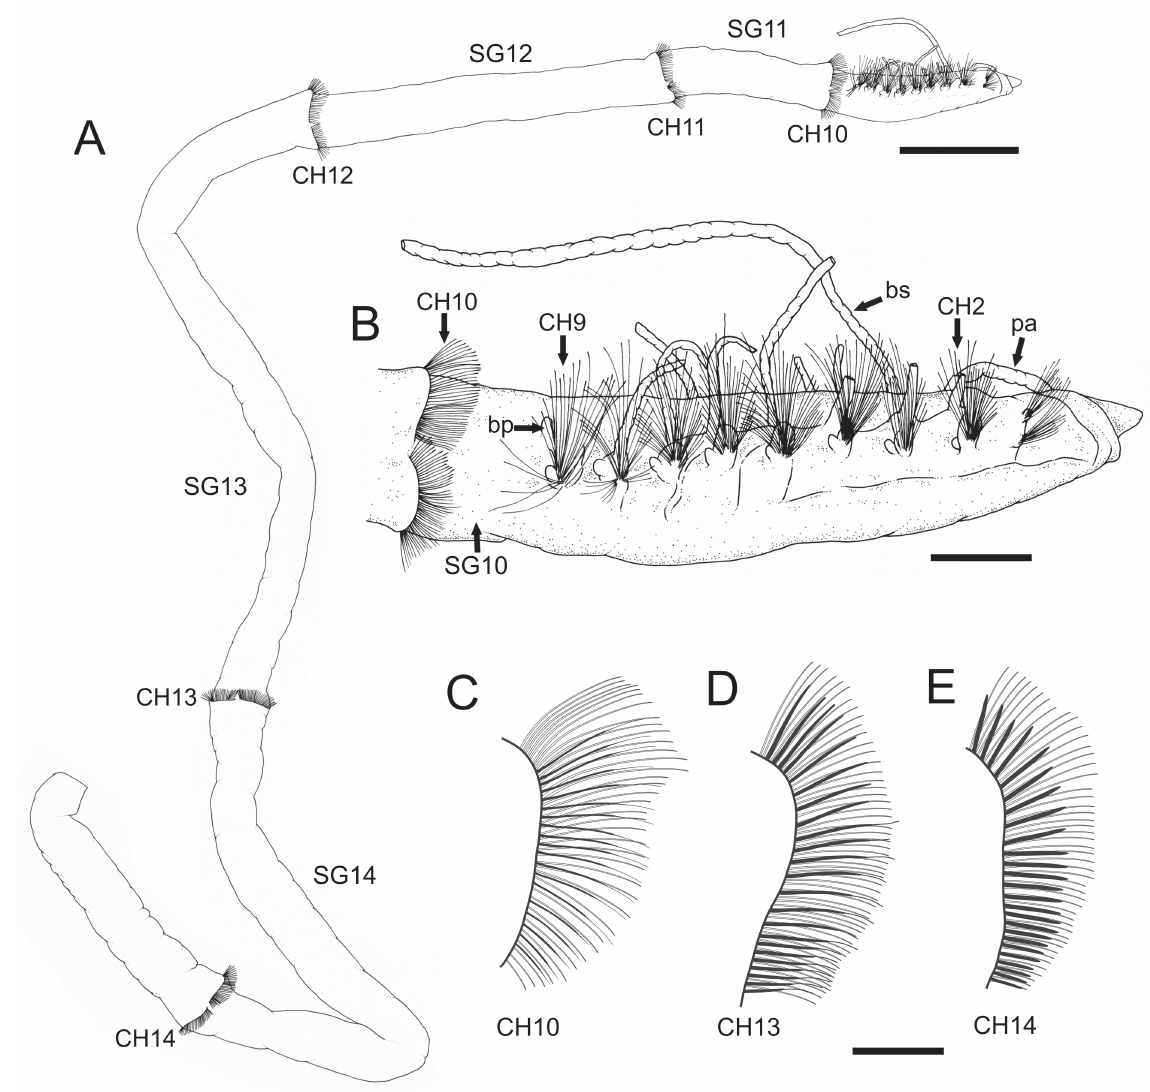
Fig. 2. Heterospio indica sp. nov., holotype (MNCN 16.01/16996). A . General view (scale bar = 2 mm). B . Anterior end, lateral view (scale bar = 400 m m). C–E . Chaetal arrangement (scale bar = 200 m m), details. C . CH10. D . CH13. E . CH14. Abbreviations: bp = branchiophore; bs = branchiostyle; CH